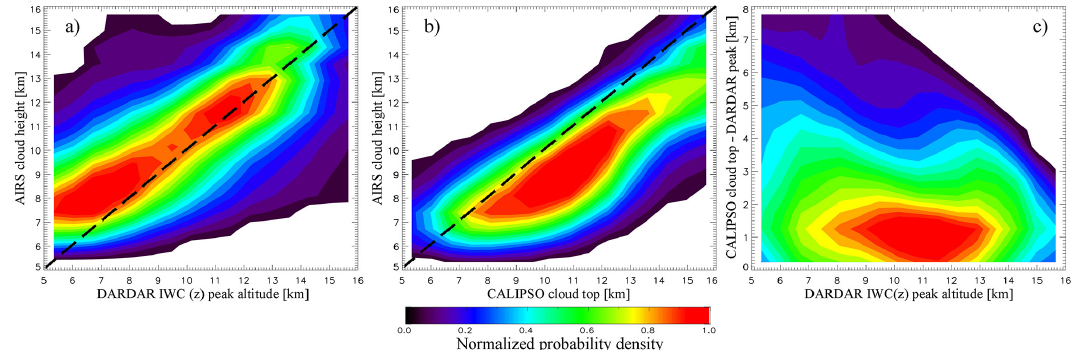
Figure 3. Probability density plots of height comparisons for high ice clouds for the whole globe in January 2007: (a) AIRS z cld vs. DARDAR peak height; (b) AIRS z cld vs. CALIPSO z top ; (c) CALIPSO z top – DARDAR peak vs. DARDAR. Dashed lines in (a) and (b) : one-to-one